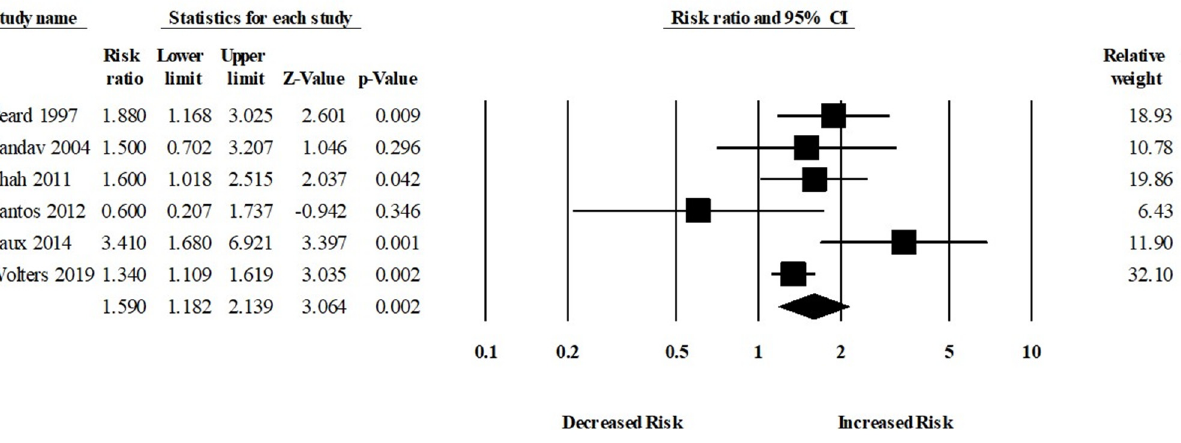
Figure 4. Association between anemia and Alzheimer’s disease [18,19,23,24,27,34].